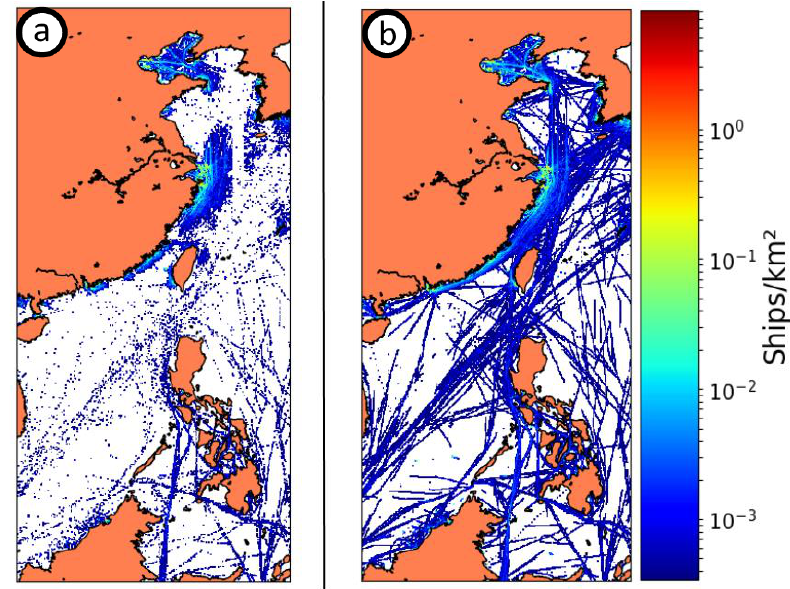
ffi c density derived from non-interpolated ( a ) and interpolated ( b ) AIS Figure 6. Traffic density derived from non-interpolated ( a ) and interpolated ( b ) AIS dataset. Figure 6. Tra